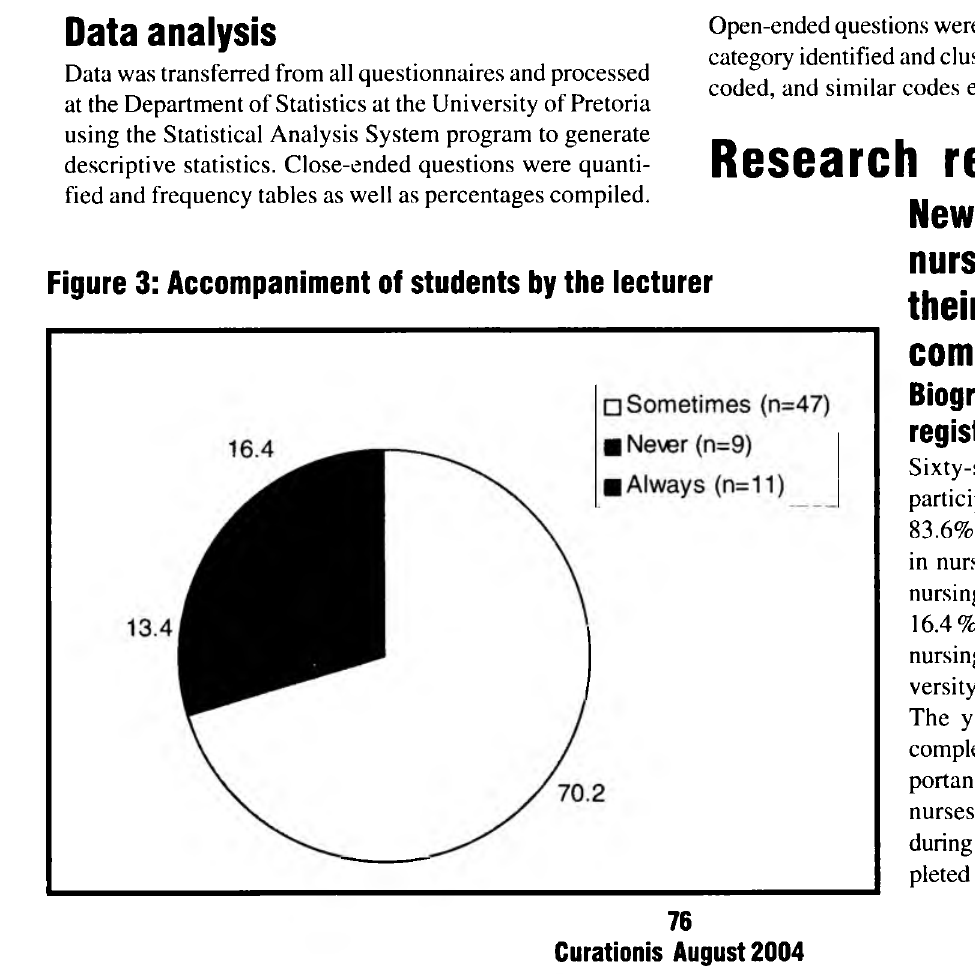
Figure 3: Accompaniment of students by the lecturer